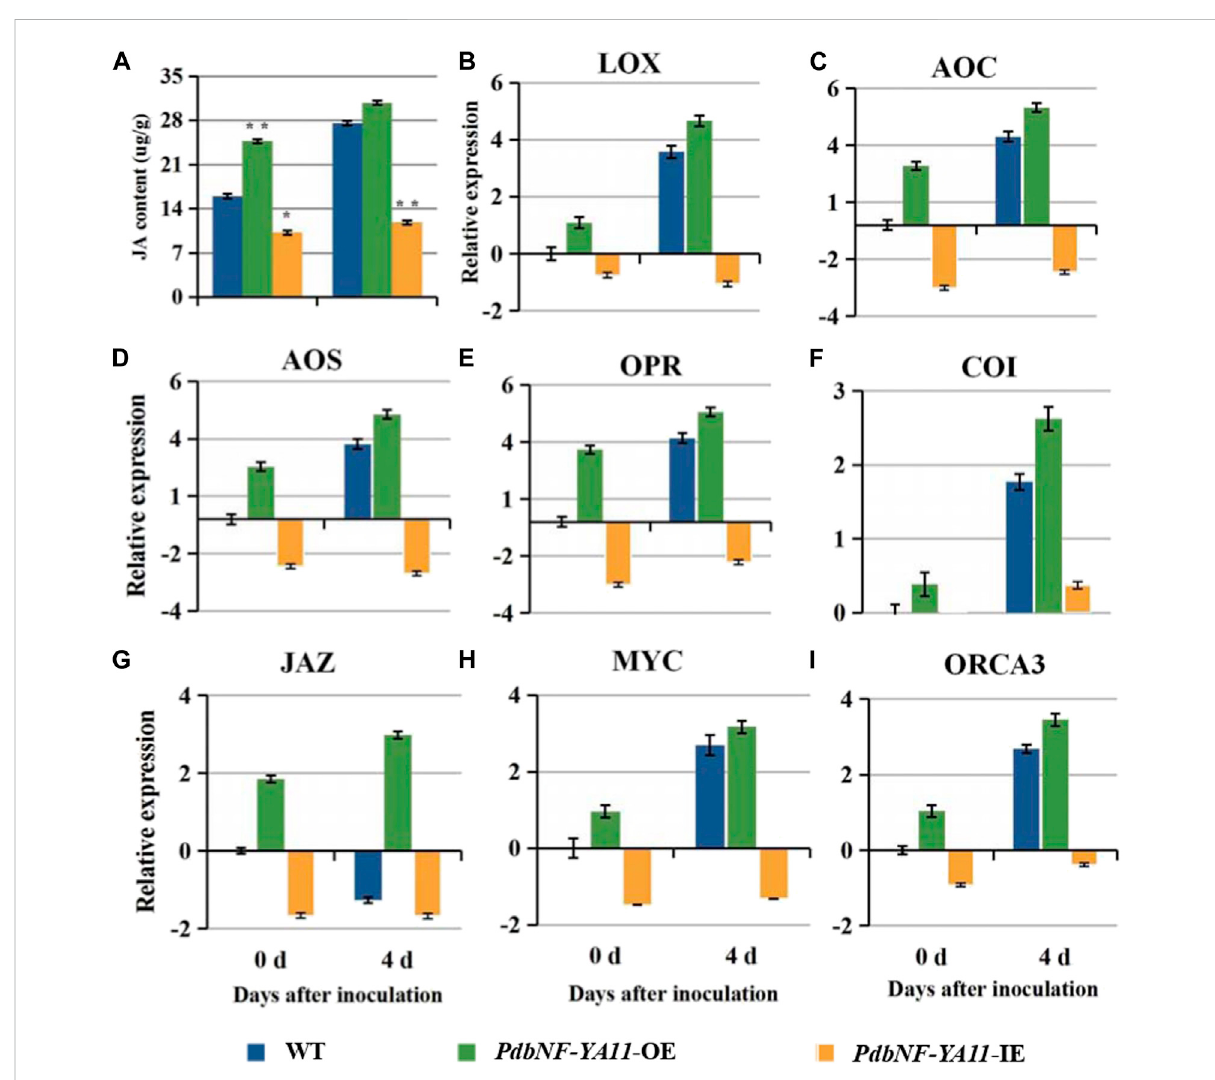
FIGURE 9 PdbNF-YA11 regulatesJAsignaling. (A) JAcontentsinWTandtransformedplants. (B) – (I) RelativeexpressionlevelsoftheJAbiosyntheticandJA signaling pathway genes. The error bars represent the standard deviation of triplicate assays. Asterisks show signi fi cant differences between inoculated and noninoculated leaves (** p < 0.01 and * p < 0.05).